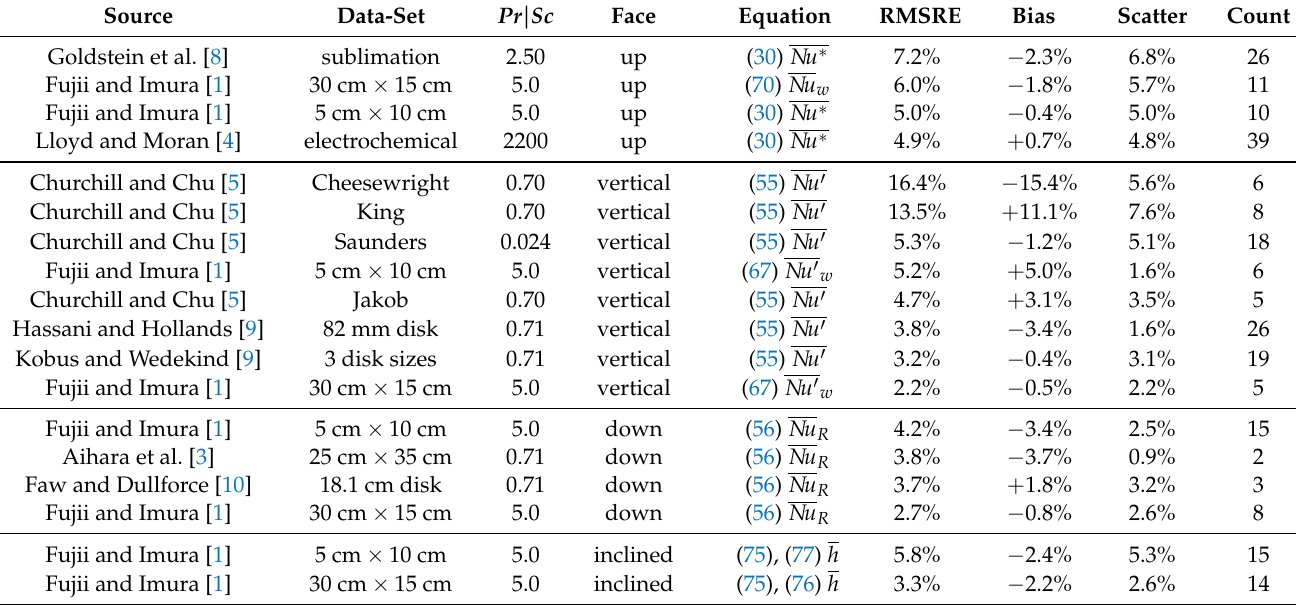
Table 13. Measurements versus present